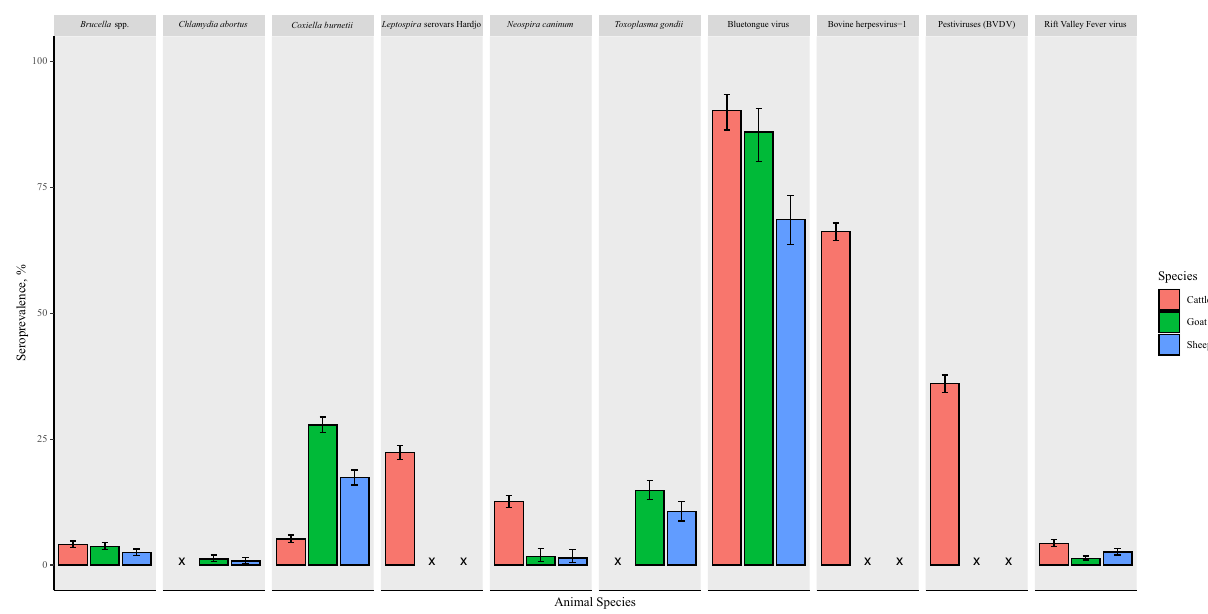
Figure 2. Seroprevalence of pathogens from cross-sectional studies (2013–2015 and 2016) in cattle, goats, and sheep, northern Tanzania. Where x = not tested and error bars represent Clopper-Pearson 95% confidence